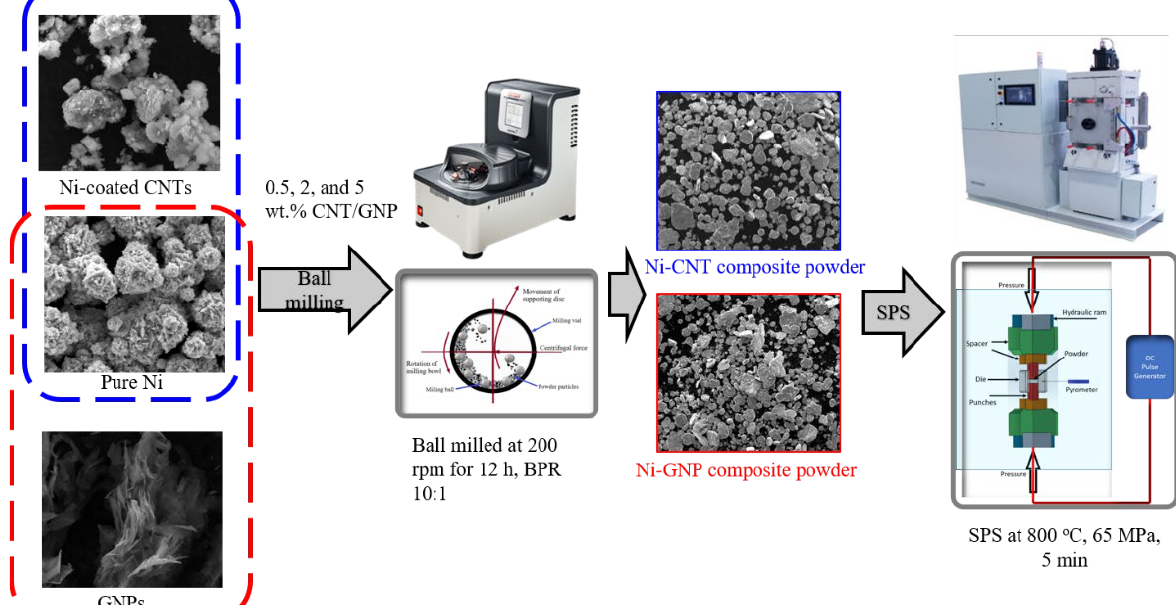
Figure 1. Schematics for processing of Nickel-Carbon nanotubes (Ni-CNT)/ Nickel-Graphene nanoplatelets (Ni-GNP) composites.